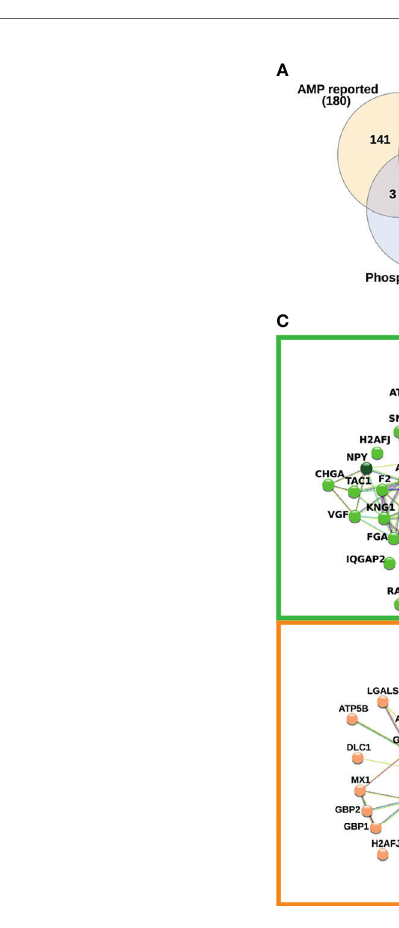
FIGURE 7 | Mapping of proteins with antimicrobial peptide function across the four brain regions. (A) Venn diagram representing the overlap between our current proteomic data set and proteins with previously reported antimicrobial peptide activity. (B) Venn diagram showing the overlap of AMPs across all brain areas in this study. (C) Interaction network between the identi fi ed AMPs in each investigated brain area. Nodes highlighted with darker colors represent proteins with changes in their relative